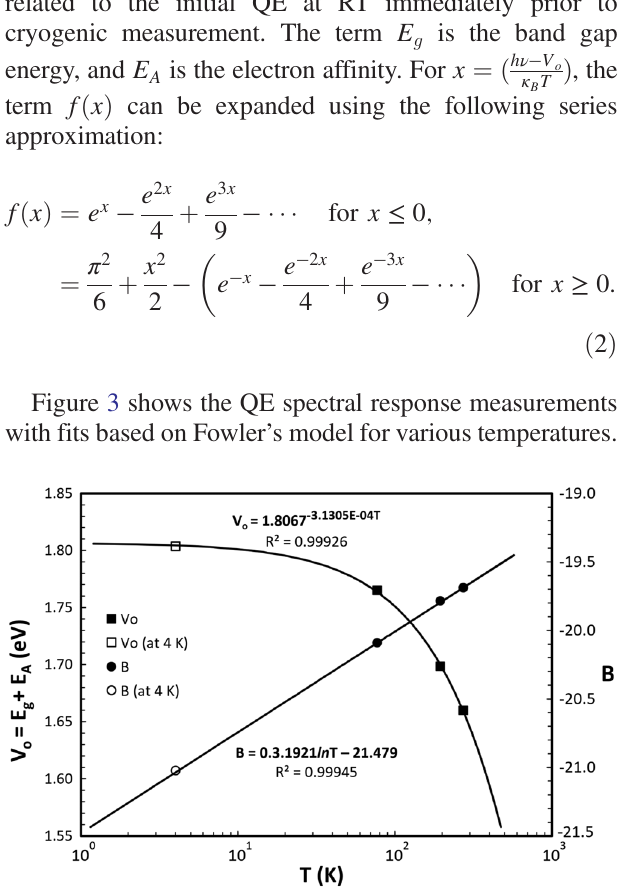
FIG. 3. QE spectral response from the Cs a wavelength tunable laser. The axes units were chosen based on Fowler ’ s model and Eq. (1).